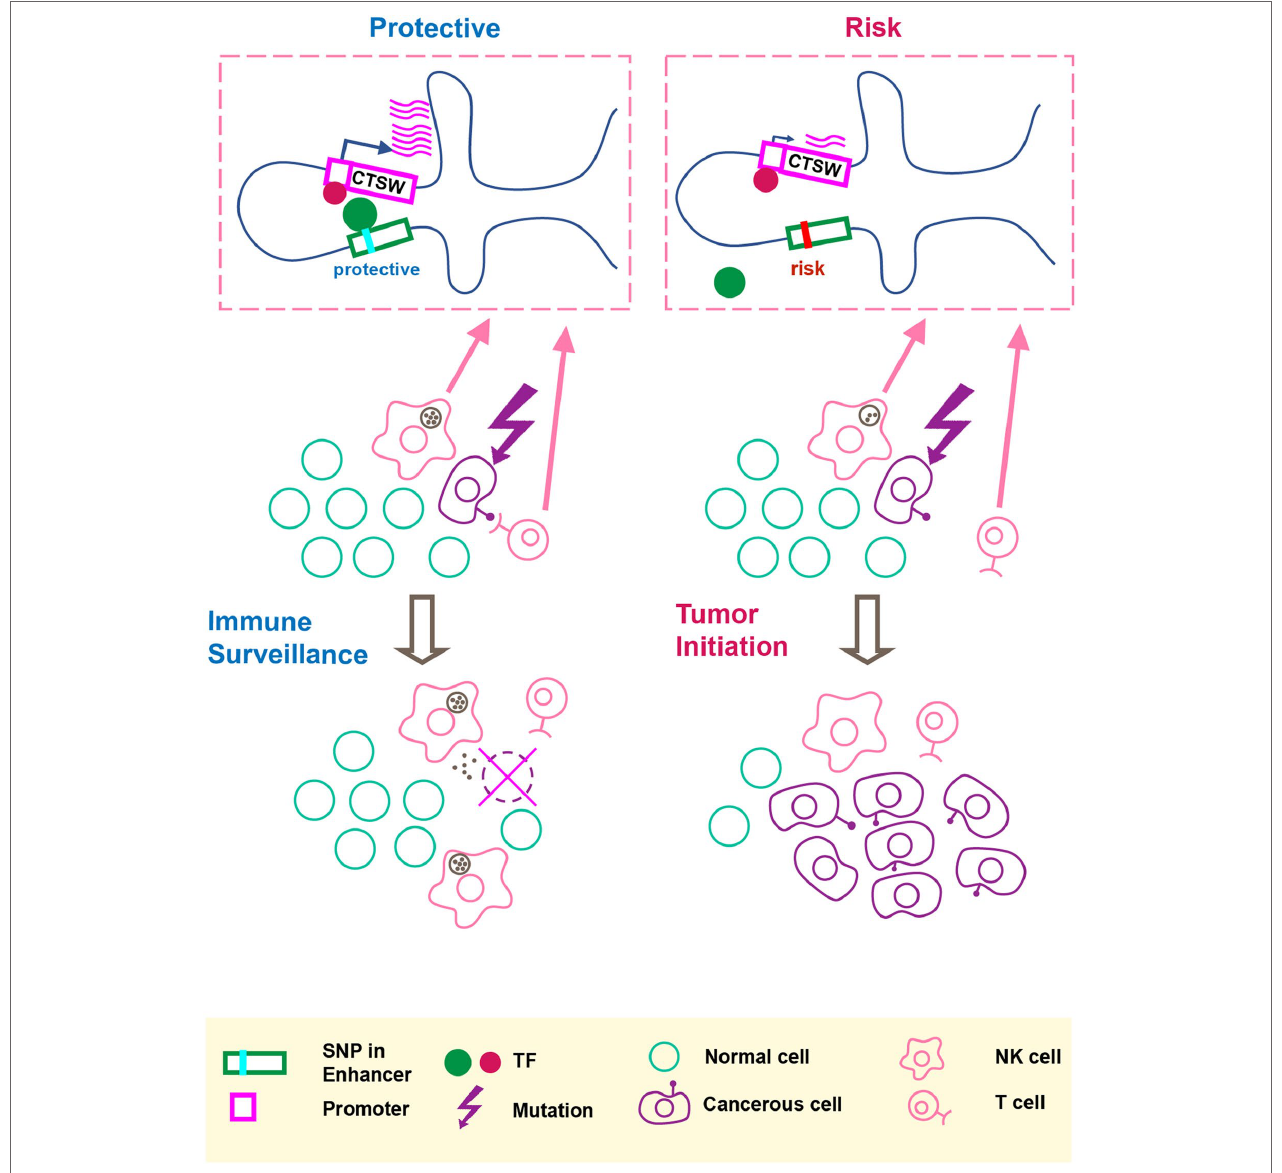
FIGURE 4 | An illustration of our hypothesis. The putative molecular gene-regulation process is shown in the top boxed panels, and the tumor initiation process is illustrated in the two rows below. The left panel shows the process of cancer immune surveillance in people carrying the protective alleles at the GWAS SNP and the predicted functional enhancer SNP. In the top left box, the chromosome carrying the protective alleles produces an abundant CTSW mRNA level; as shown here, CTSW transcription could be elevated through a transcription activator binding the PRE1 SNP. Note that another scenario, not shown in the illustration, is also possible, where the protective allele could disrupt the binding motif of a transcription repressor. Going back to the cell view, the high level of CTSW expression in NK cells or T cells may enhance their cytotoxicity and facilitate their ability to detect and eliminate abnormal cells, such as cancerous mammary epithelial cells that just acquired some oncogenic mutations. This high efficiency of immune surveillance would thus reduce the risk of developing breast cancer. By contrast, the right panel shows the NK/T cells with suppressed CTSW expression associated with the risk alleles, resulting in reduced cytotoxic activities and suppressed immune surveillance efficiency, thereby increasing the risk of developing breast